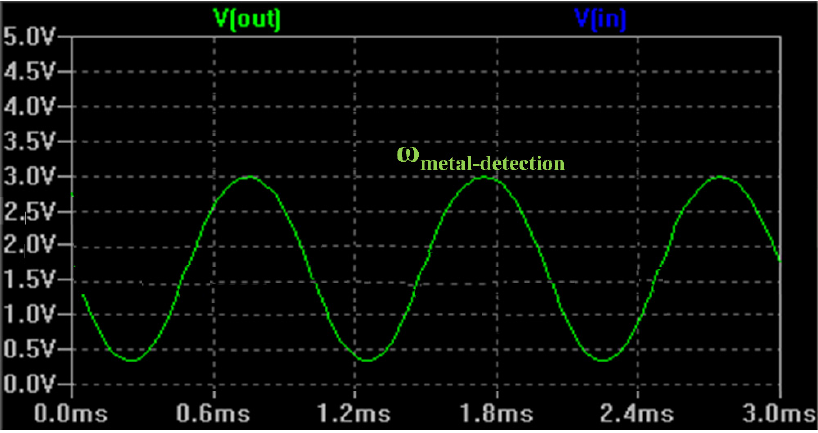
Figure 10. Simulation result of the sine waveform with metal (clip) detection for Colpitts oscillator and metal clip.